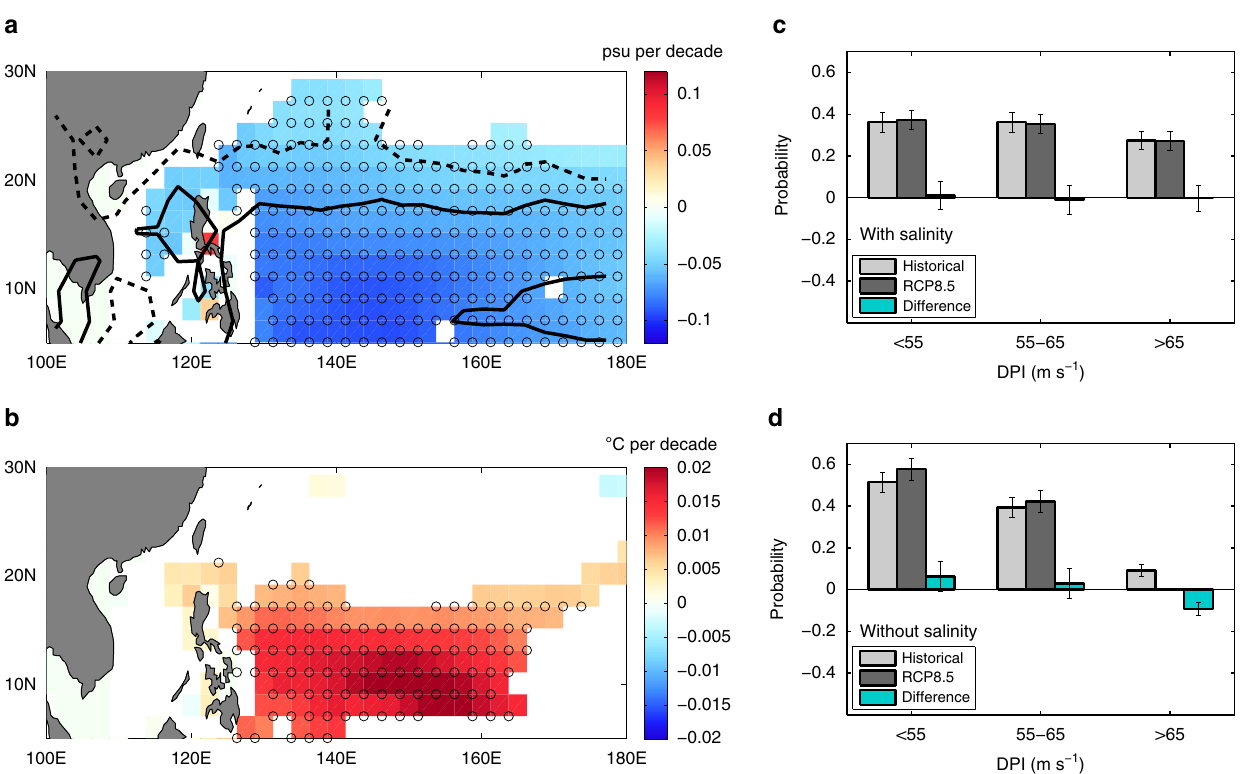
Figure 3 | Projected 100-year changes in salinity impacts on super typhoon intensification based on the CMIP5 multi-model ensemble mean. ( a ) Changes in sea surface salinity (psu per decade) with contours of precipitation changes overlaid: the solid contour represents a precipitation change of 0.1mm per day per decade, whereas the dashed contour represents a precipitation change of 0.05mm per day per decade. ( b ) Contribution of salinity to changes in super typhoon (STY) cold wakes ( (cid:2) C per decade). In a , b , changes shown are statistically significant at the 95% level and locations where more than 15 out of 18 models agree on the sign of the change are marked in circles. PDFs of typhoon-season mean Dynamic Potential Intensity (DPI) distribution in ms (cid:2) 1 , ( c ) with and ( d ) without salinity, for STYs and for the region between 130 (cid:2) E–150 (cid:2) E and 5 (cid:2) N–25 (cid:2) N (see box in Fig. 1a). The PDFs for the historical period, based on years 1981–2000, are given in light grey. The PDFs for the future, based on years 2081–2100 under the RCP 8.5 scenario, are given in dark grey. The difference between the PDFs with and without salinity is given in cyan. For the PDFs shown in c , d , each bin size and the corresponding error bar, represented by ± one s.d., were computed based on the Monte Carlo method of repeated random sampling (see